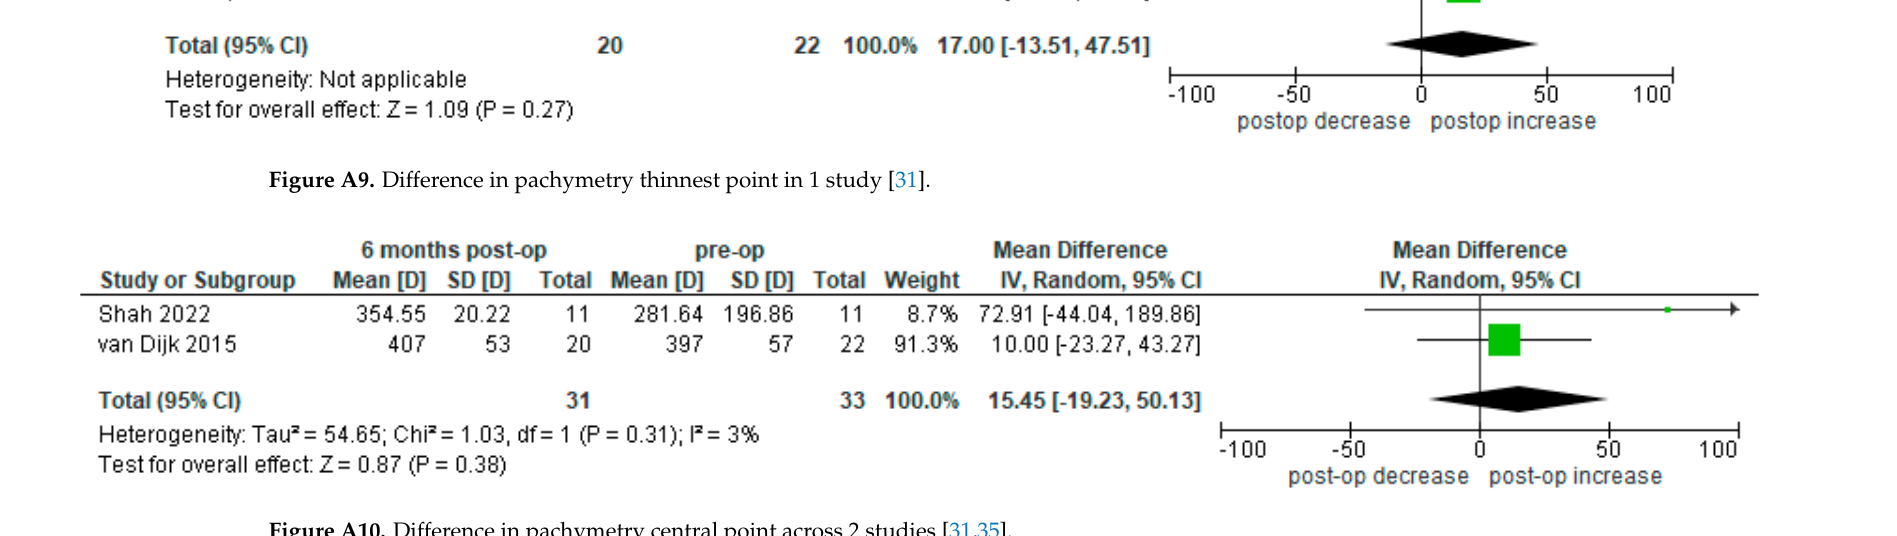
Figure A10. Difference in pachymetry central point across 2 studies [31,35]. Figure A10. Di ff erence in pachymetry central point across 2 studies [31,35]. Figure A10. Di ff erence in pachymetry central point across 2 studies [31,35].